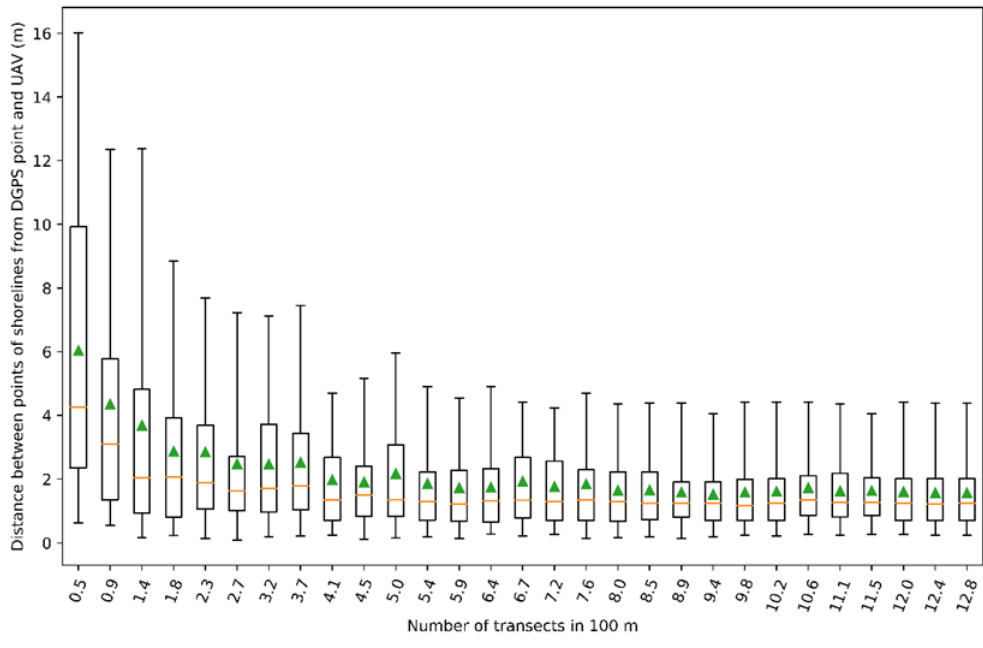
Figure 5. Analysis of errors between shoreline points derived from DGPS points and those derived from DEM by Structure from Motion (SfM) processing. The errors are the distance between two relative points of shorelines along 112 transects derived from DGPS points. The box represents the 25th and 95th percentiles, the orange line the median, the green triangle the mean, and the whiskers the 5th and 95th percentiles.